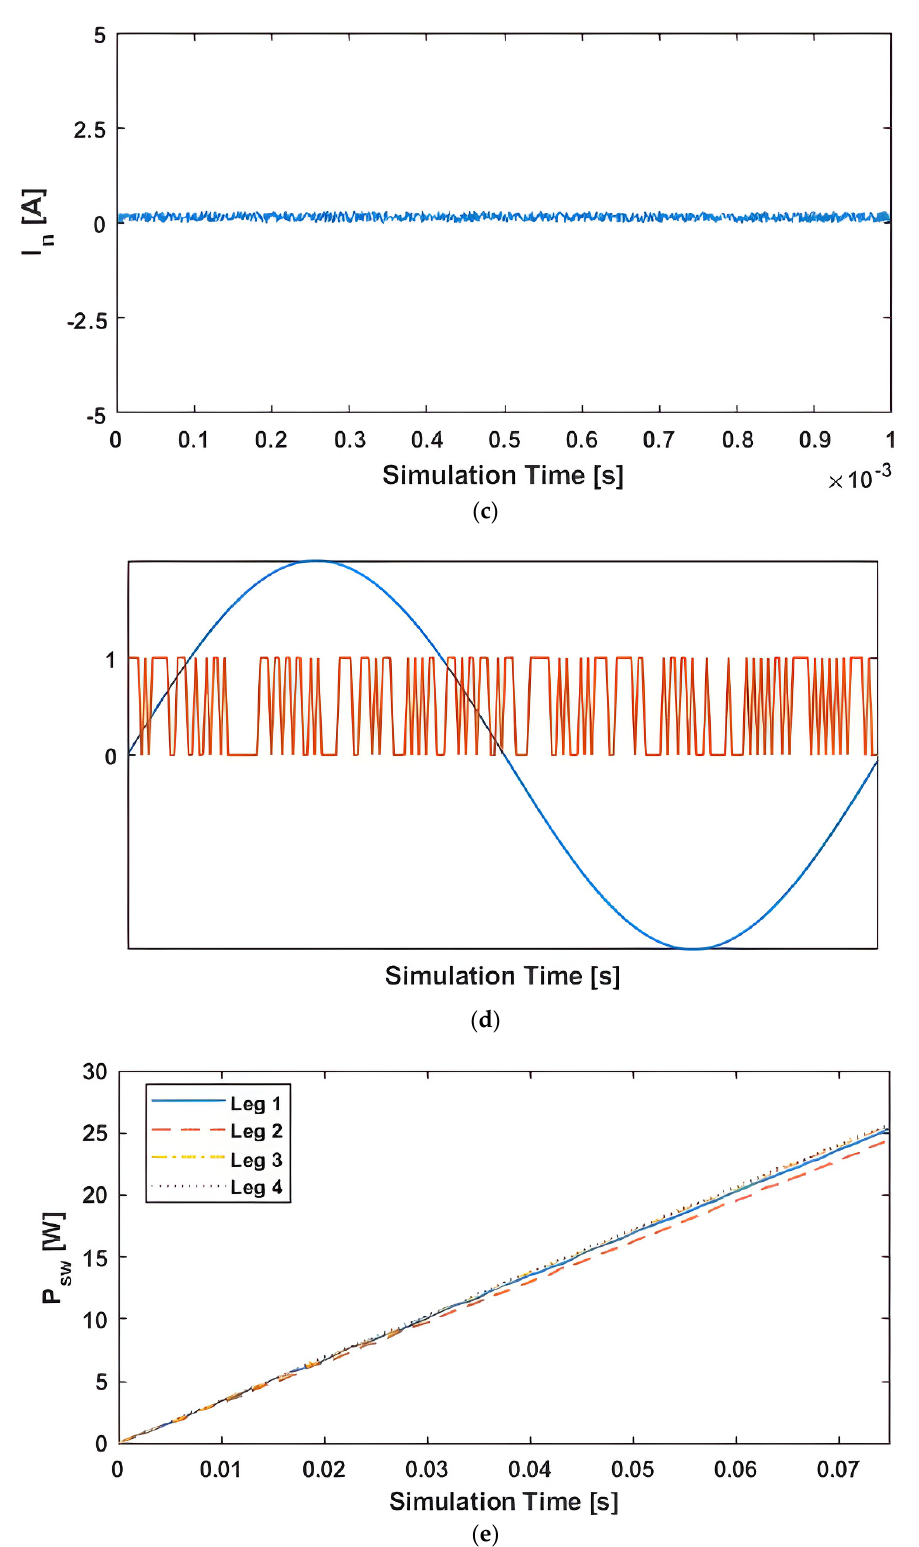
Figure 4. ( a ). V abc -Mode II with Balanced Reference Currents. ( b ). I abc -Mode II with Balanced Reference Currents. ( c ). I n -Mode II with Balanced Reference Currents. ( d ). Switching frequency for one duty cycle-Mode II with Balanced Reference Currents. ( e ). Switching losses-Mode II with Balanced Reference